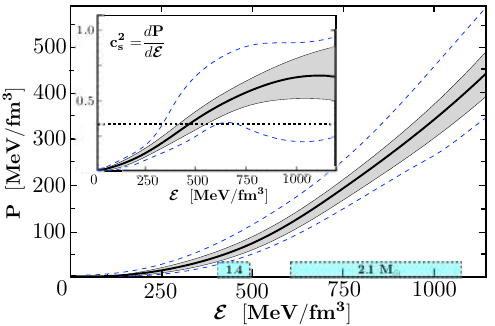
Figure 2. Pressure P ( ε ) as function of energy density and squared sound speed c 2 s ( ε ) of neutron star matter using Bayesian inference with data listed in Section 2.1. Displayed are medians (solid curves), 68% (grey) and 95% (dashed) credible bands. The sectors on the lower axis mark the ranges of central energy densities realised in the cores of 1.4 and 2.1 M ⊙ neutron stars, respectively. Adapted from [16].